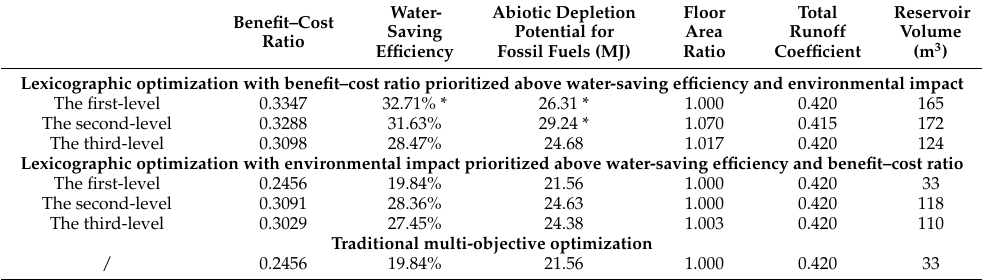
Table 4. Benefits analysis of community-based rainwater utilization scheme at each level.